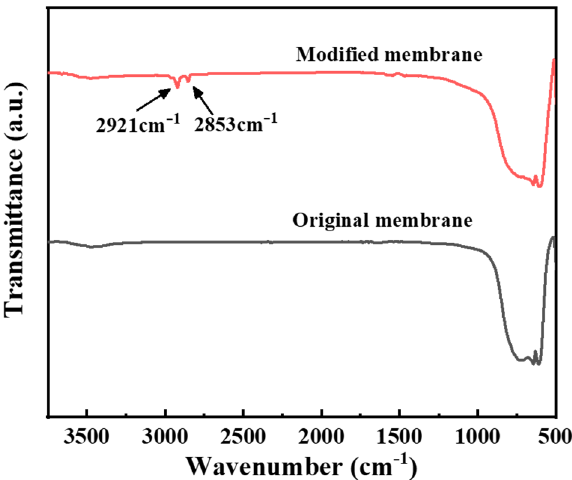
Figure 4. Fourier transform infrared spectrum (FTIR) of the α -Al 2 O 3 membrane before and after modification.